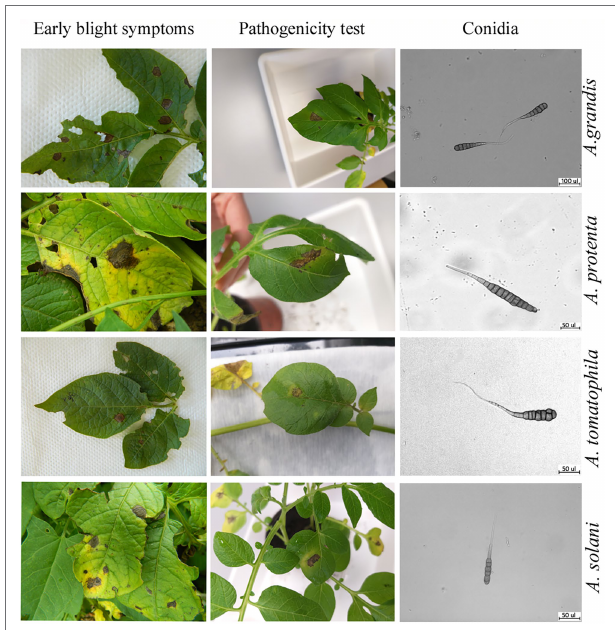
FIGURE 4 | (A) Symptoms of early blight on potato; (B) pathogenicity test 7 days after inoculation (C)